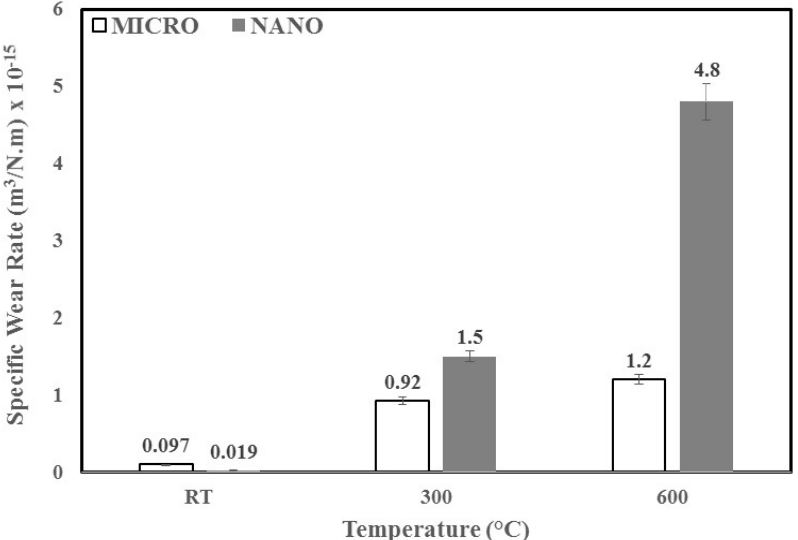
Figure 3. Variation in the specific wear rate with WC particle size and test temperature at a constant sliding velocity of 0.1 m/s and a normal load of 30 N under dry conditions.